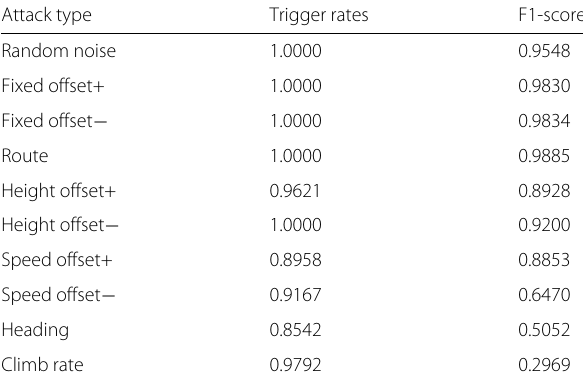
Table 5 Trigger rates of various